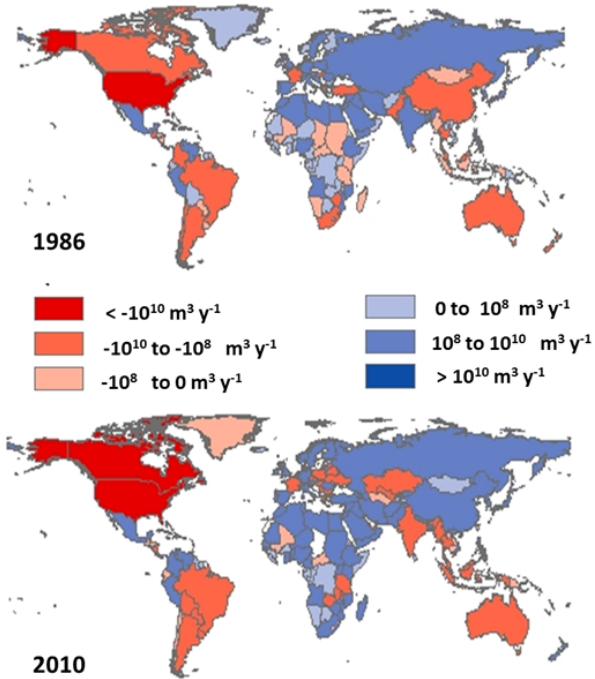
Fig. 2. Net grey water trade (imports–exports in m 3 yr − 1 ) in 1986 and 2010. The red countries are grey water net exporters, meaning that they are burdened with agricultural pollution from virtual wa- ter that was subsequently transferred to other countries. The blue countries are grey water net importers, meaning that they exter- nalize agricultural pollution by importing virtual water from other countries. The identities of large net importers and exporters were relatively static over the 25yr record. However, countries, such as China,